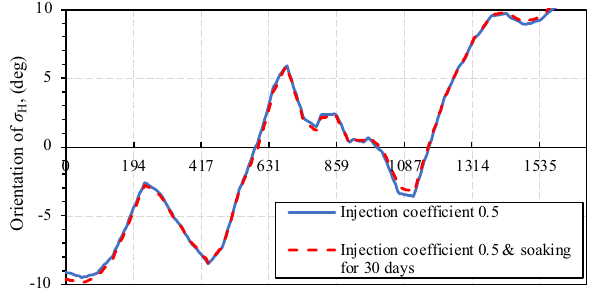
Fig.14 Orientation angle of maximum horizontal stress along the M-I2 wellbore at different soaking time spans